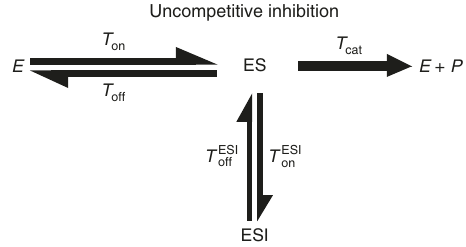
Fig. 4 A generic scheme for uncompetitive inhibition at the single-enzyme level. Transition rates have once again been replaced with generally distributed transition times to generalize the Markovian scheme in Fig.